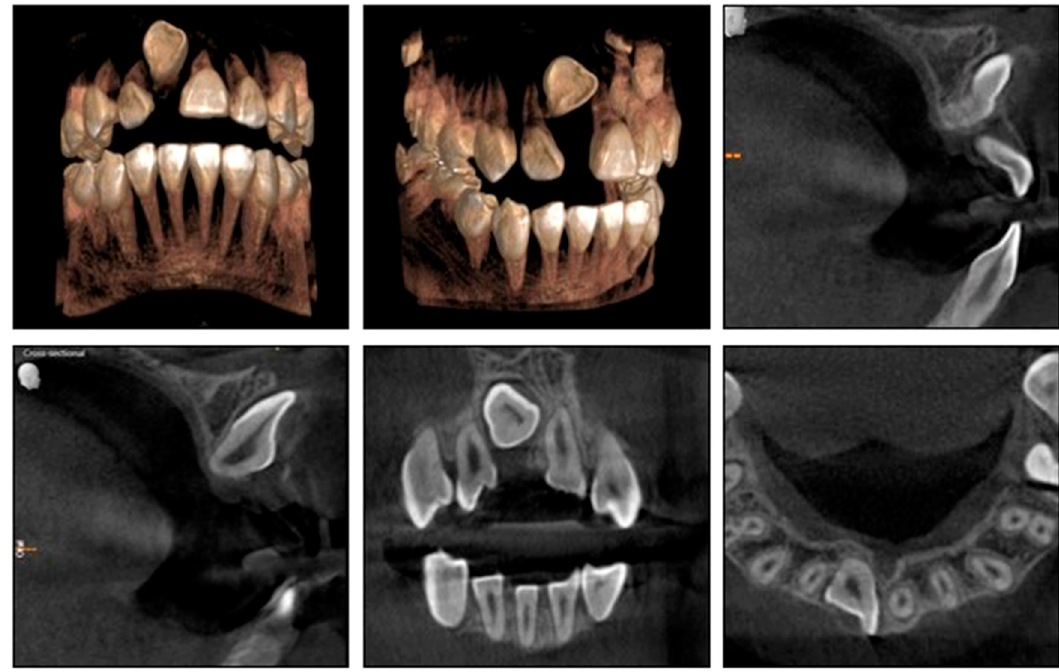
Figure 5. Pre-treatment cone-beam computed tomography (CBCT).